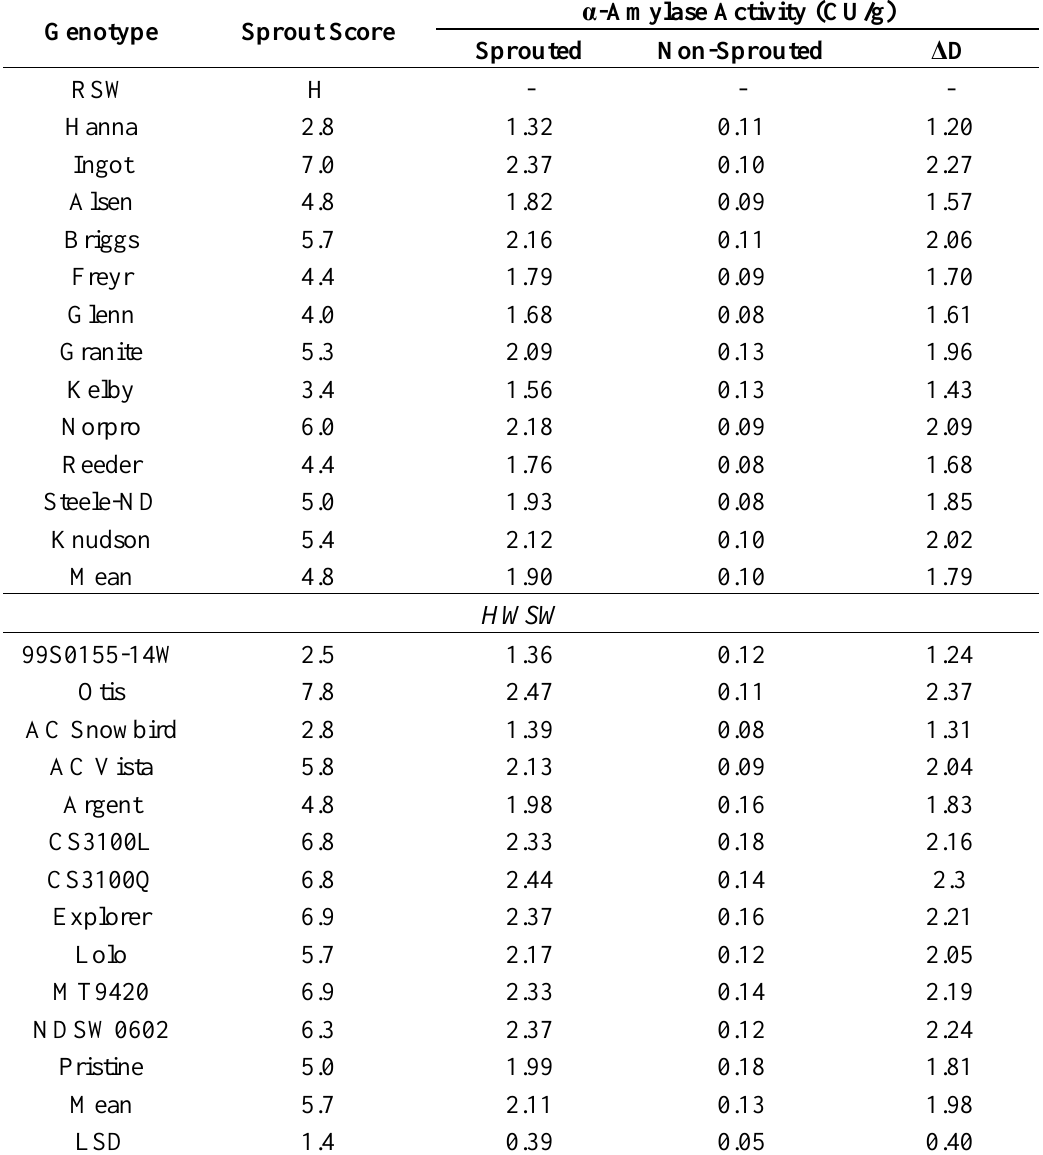
Table 1. Sprouting score and α-amylase activity of sprouted wheat, non-sprouted wheat and their difference